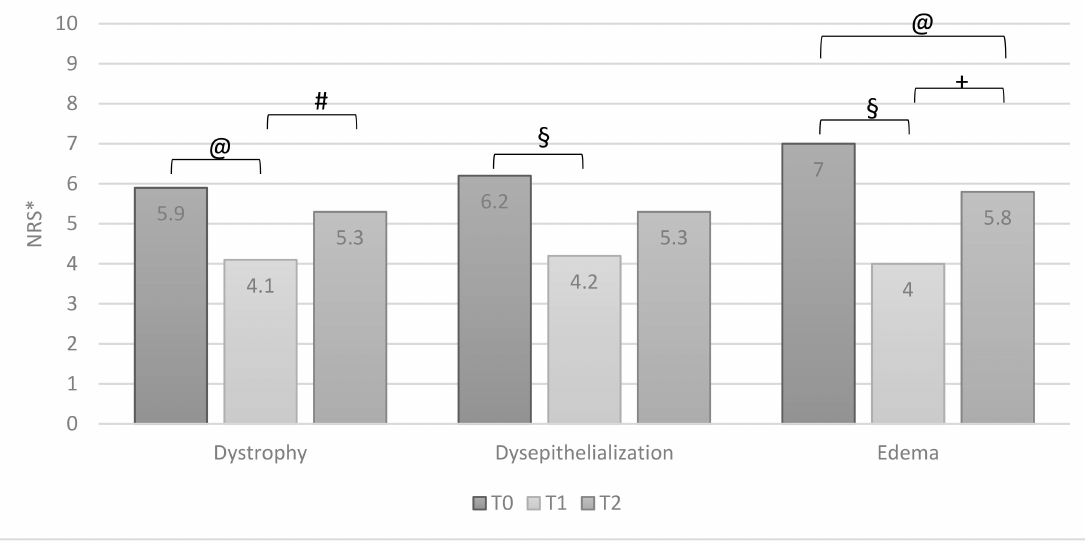
Figure 3. Group A: patients’ signs of inflammation T0, T1 and T2 (ANOVA test, values are means). * NRS: Numeric Rating Scale, 10-point scale. @ p = 0.001; # p = 0.04; § p = 0.0001; + p =